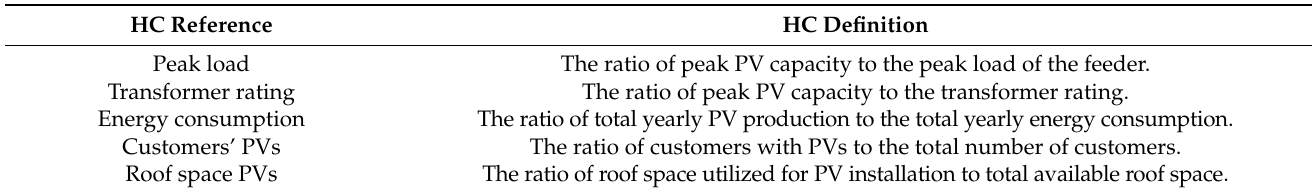
Table 3. Different definitions of HC w.r.t varying references